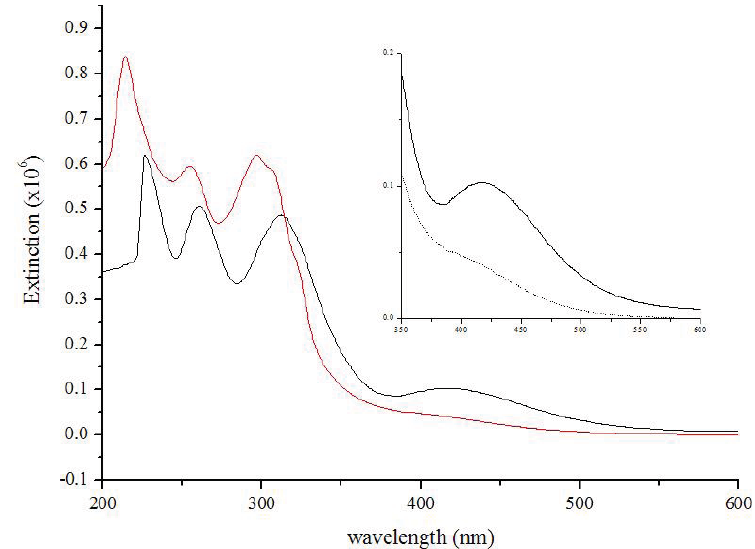
Figure 2. UV-visible spectra of complex in CH